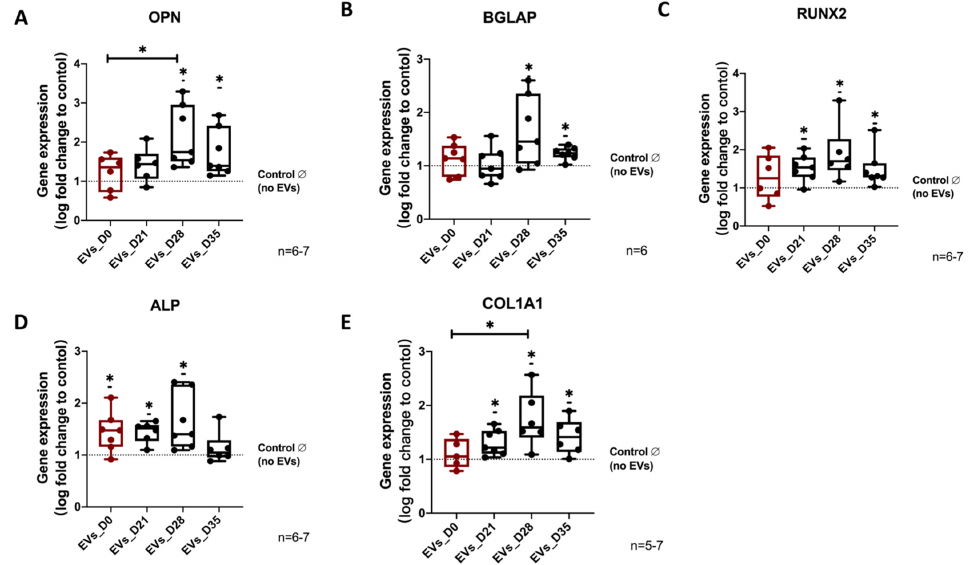
Figure 5. Evaluation of osteogenic marker gene expression in hBMSCs after EV treatment. ( A – E ) Gene expression level of the osteogenic marker genes (OPN, BGLAP, ALP, RUNX2, and COL1A1) were analyzed after 14 days of osteogenic differentiation of hBMSCs and simultaneous stimulation with the different EV groups. Results were calculated as percentage to the control group (no EVs, shown by the dotted line); * p < 0,05; Wilcoxon signed-rank test was used when no EVs group was set to 100%, and two-tailed Mann–Whitney U-test was used to compare differences between differ- ent EV-treated groups; n = 5–7.